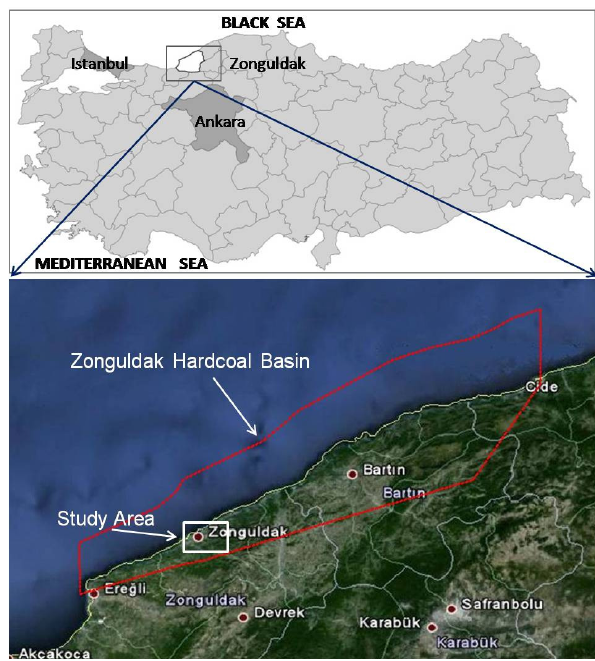
Figure 1. Location of Zonguldak city and TTK hard coal basin (source: GoogleEarth) Fig. 1. Location of Zonguldak city and TTK hard coal basin (source: GoogleEarth).